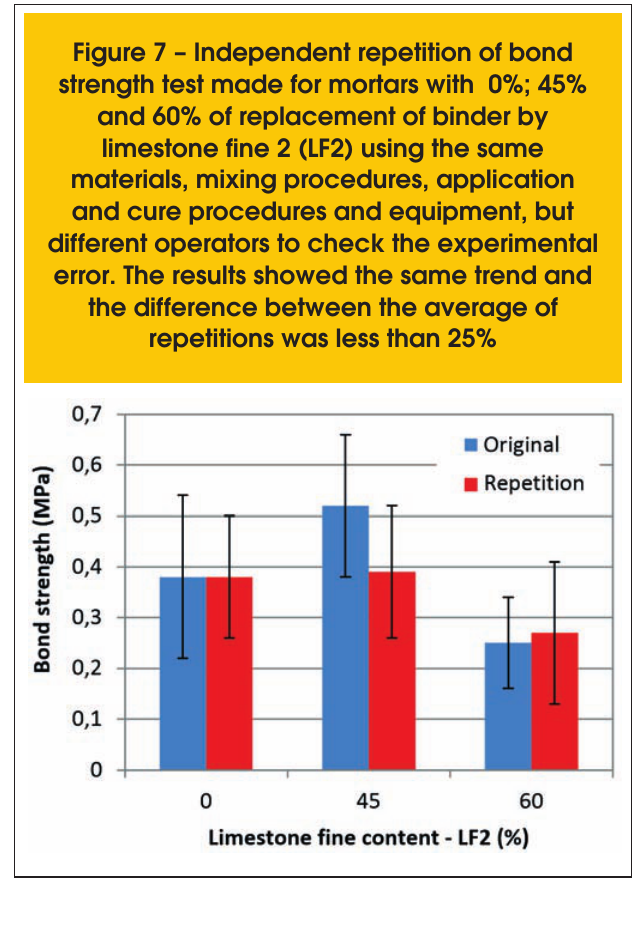
effect of dispersing mortar will be studied in future investigation.